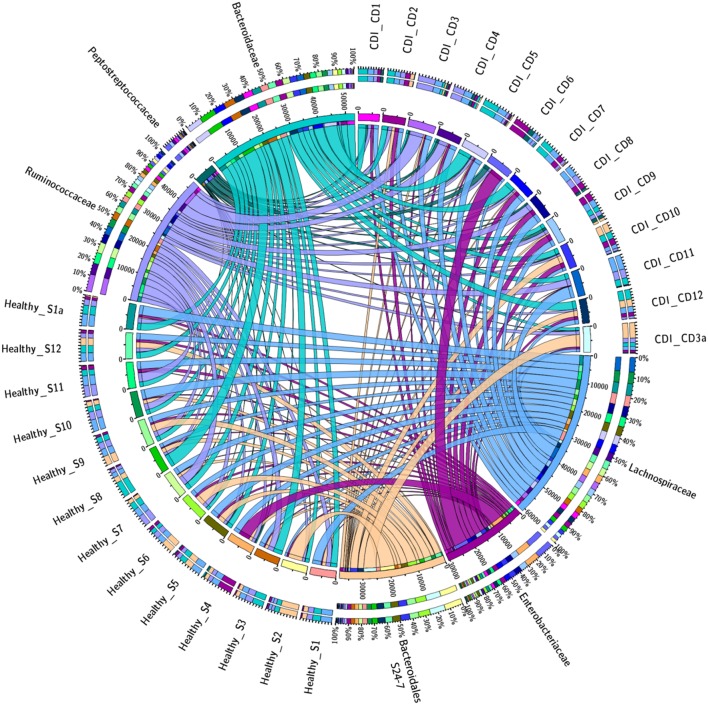
Prevalence of specific bacterial families in CDI and non-CDI cohorts. The circos plot displays relative abundance of bacterial orders within control and CDI samples. Plots were generated from a CSS normalized OTU table with all singletons removed. The abundance of each order is directly proportional to the width of each ribbon connecting bacterial taxa to its respective sample. Each bacterial family is assigned a specific color. The outer ring represents the cumulative percent of 16S sequences assigned to a given family from each sample, while the inner circle represent the number of 16S rRNA sequences assigned to a given taxa in a given sample.